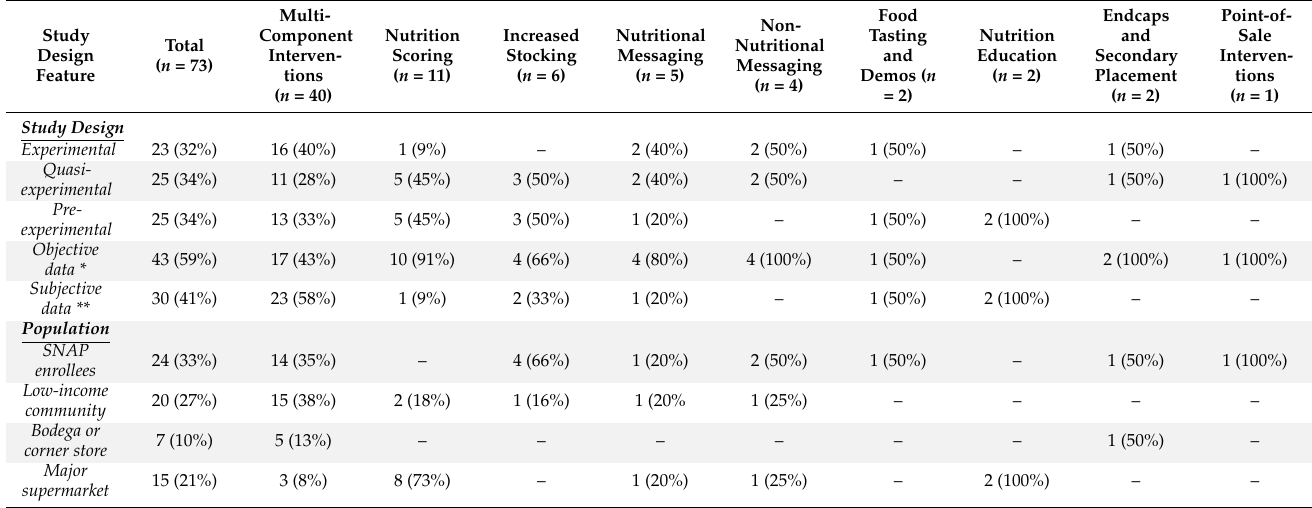
Table 2. Study Design Features of Included Articles by Intervention